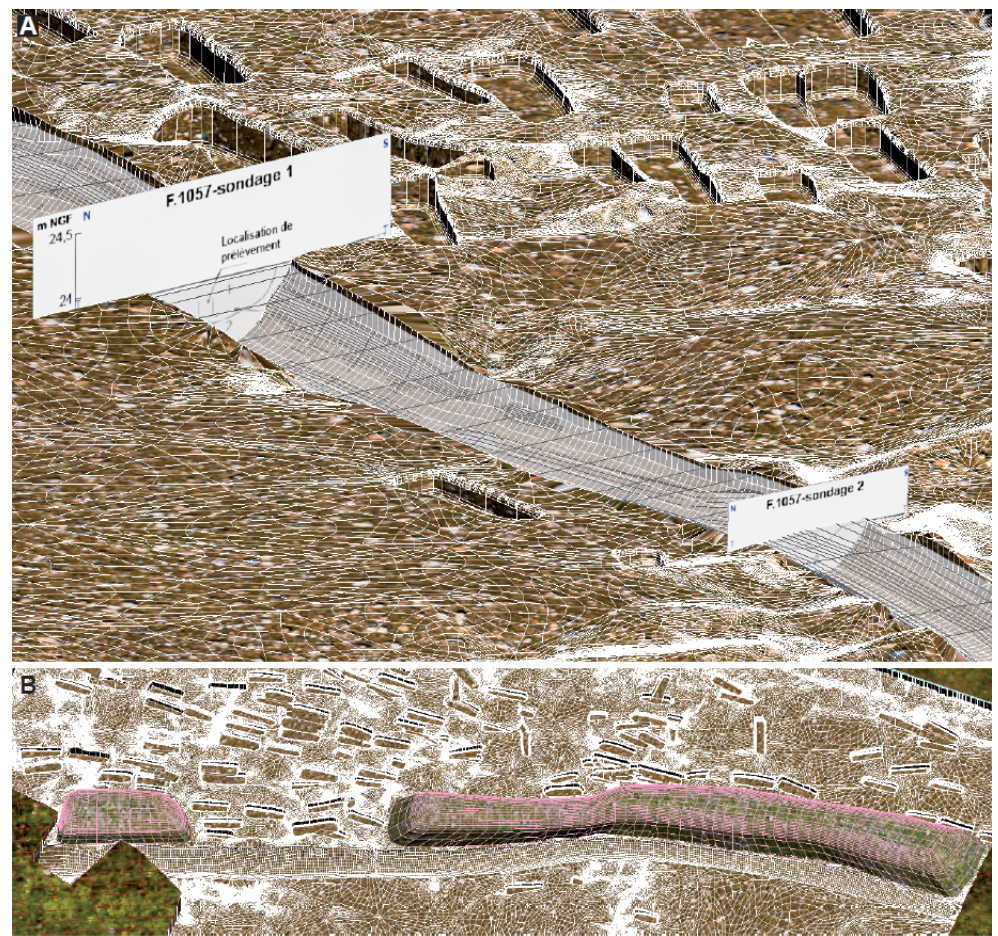
Figure 6. 3dsmax viewport showing the reconstruction of the border embankment. ( A ) digging the edge ditch on the mesh; ( B ) return of the volume of the ditch.